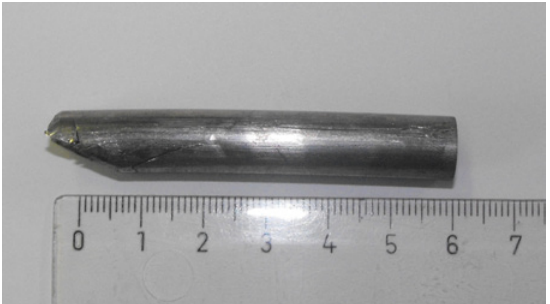
Figure 1. The experimental material after ECAP (half spec- imen).